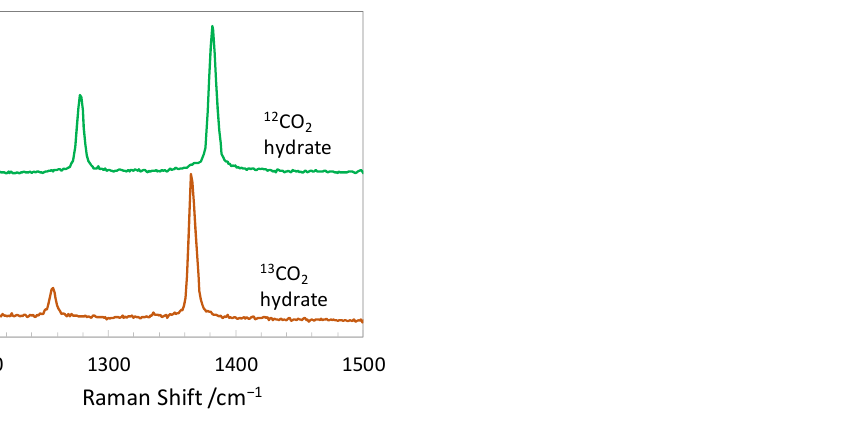
Figure 1. Raman spectra of 12 CO 2 and 13 CO 2 hydrates in the CO stretching vibration mode region of CO 2 . The spectra were recorded at atmospheric pressure and 140 K. (a.u., arbitrary units).